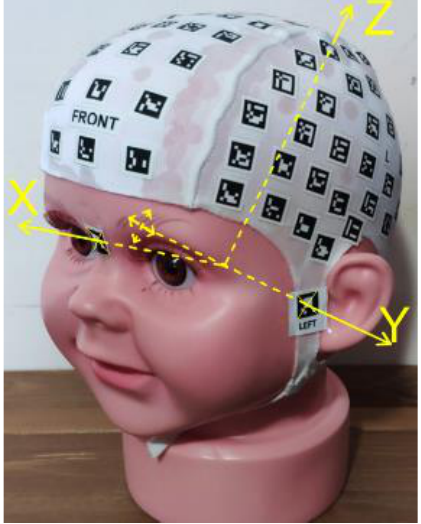
Figure 1. Dummy with the coded cap on. The local reference system (XYZ axes) is displayed in yellow.